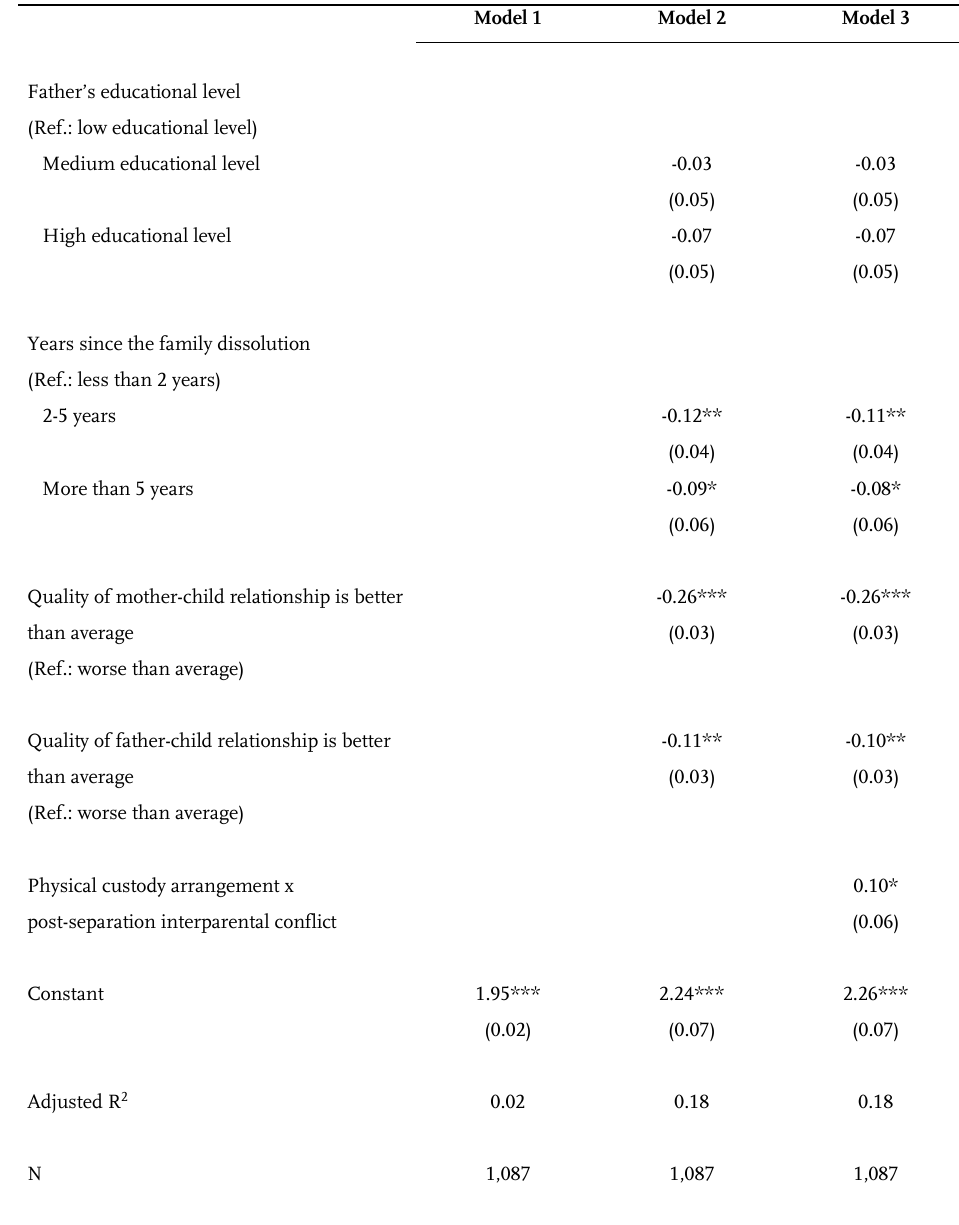
Table 2 : Linear regression models: The determinants of children’s mental health problems in post-separation families (standardized coefficients)